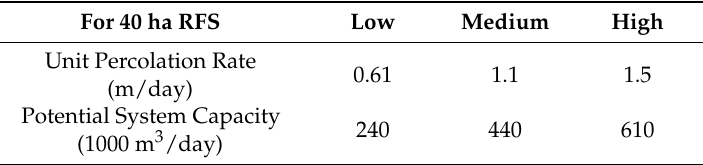
Table 5. Unit Percolation Rates and Estimated System